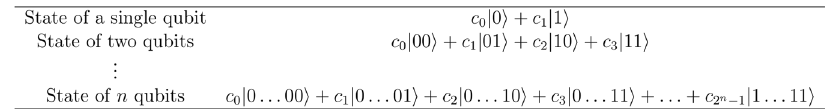
Fig. 2 General states of one-, two-, and n -qubit quantum registers. The complex expansion coef fi cients c i are supposed to satisfy the